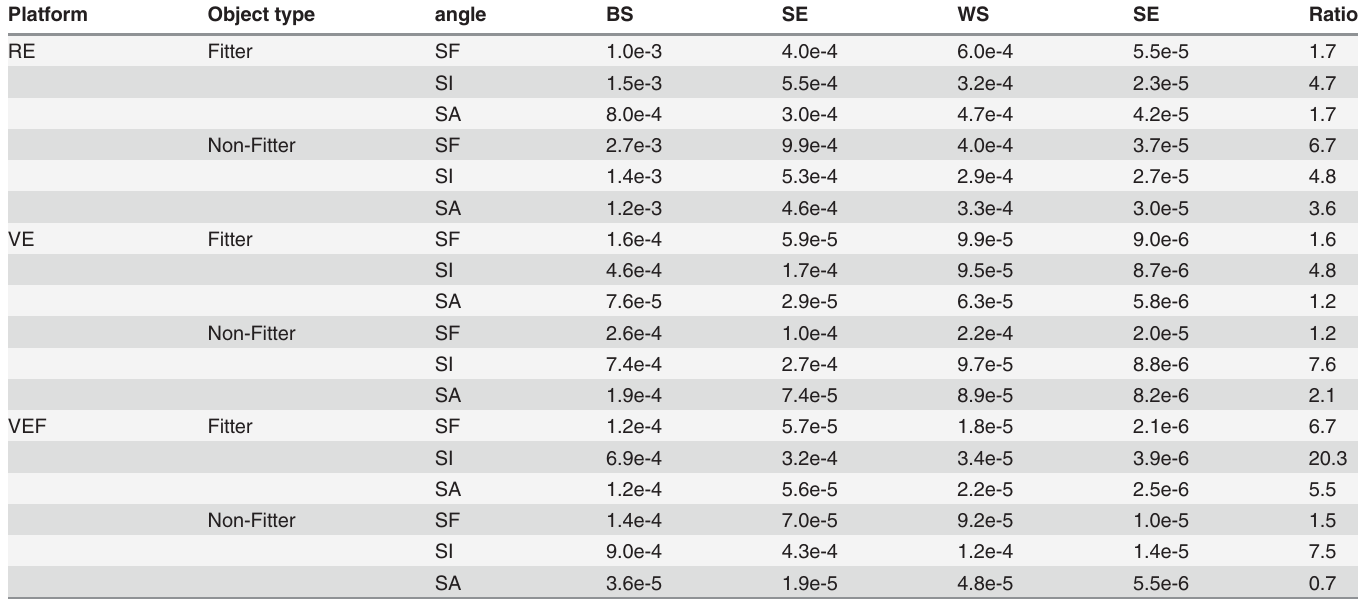
BS and WS represent the between-subject variance components and Ratio represents their ratio. SE represents the standard error of estimated variance components. RE, VE and VEF represent “ Real ” , “ Virtual ” and “ Virtual with force feedback ” platforms and “ fi tter ” and “ non- fi tter ” determine the object